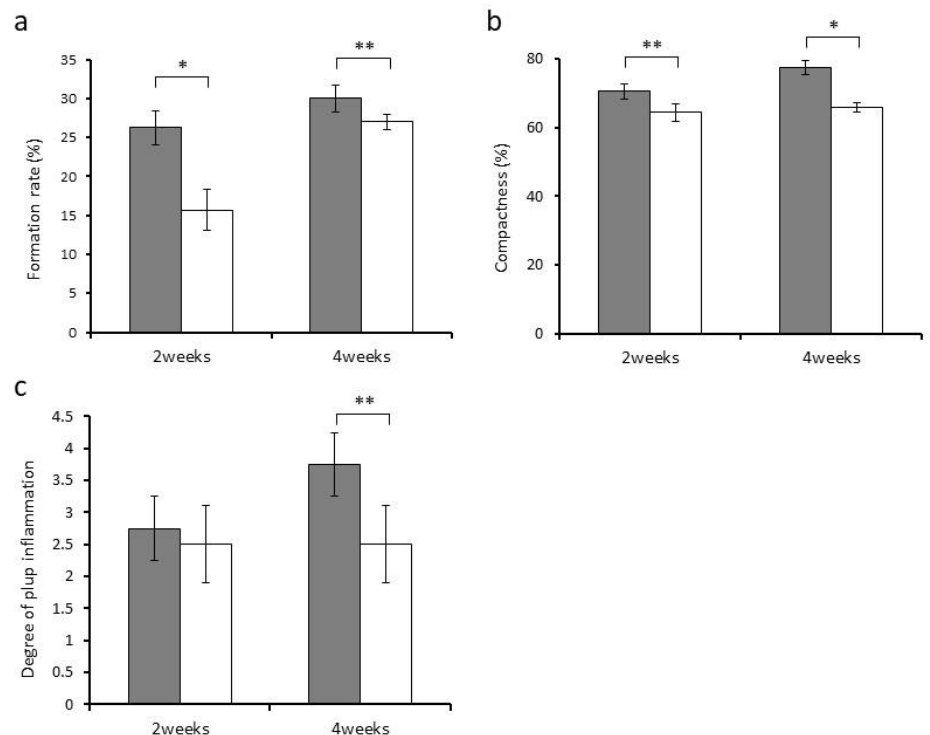
Figure 4. Evaluation of the reparative dentin formed and pulp inflammation triggered by the DPP-derived RGD-containing peptide (gray) and calcium hydroxide (white) after two and four weeks ( n = 4). ( a ) Formation rate of the reparative dentin (%). ( b ) Compactness of the reparative dentin (%). ( c ) Degree of pulpitis (score). Asterisk indicates significant differences (* p < 0.01, ** p < 0.05).